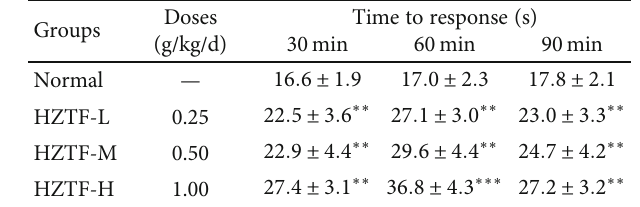
Figure 4: DAVID database enriched pathways and GO entries. (a) GO enrichment entries of the biological process showing the top 10. (b) GO enrichment entries of cellular components (the top 10). (c) GO enrichment entries of molecular function (the top 10). (d) KEGG pathway enrichment entries ( P < 0 : 05 ). Table 3: E ff ects of HZTF on white blood cells in rabbit knee joint e ff usion induced by MSU ( n = 8 ).